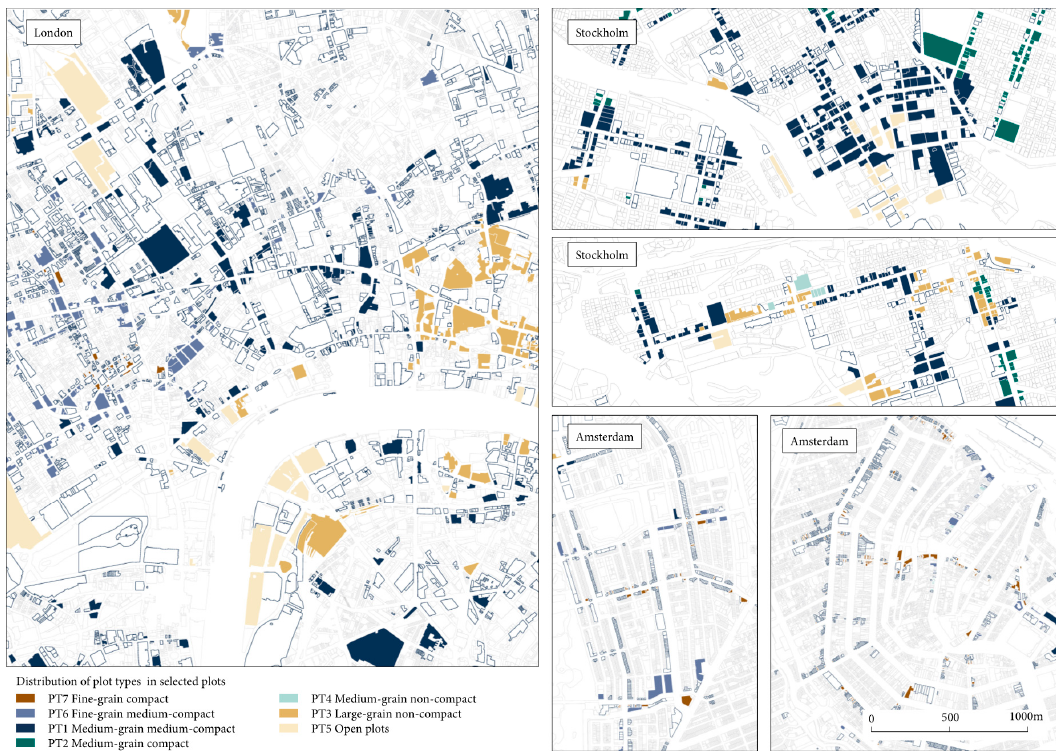
Figure 3. Concentration of economic activity within selected observations (plots).